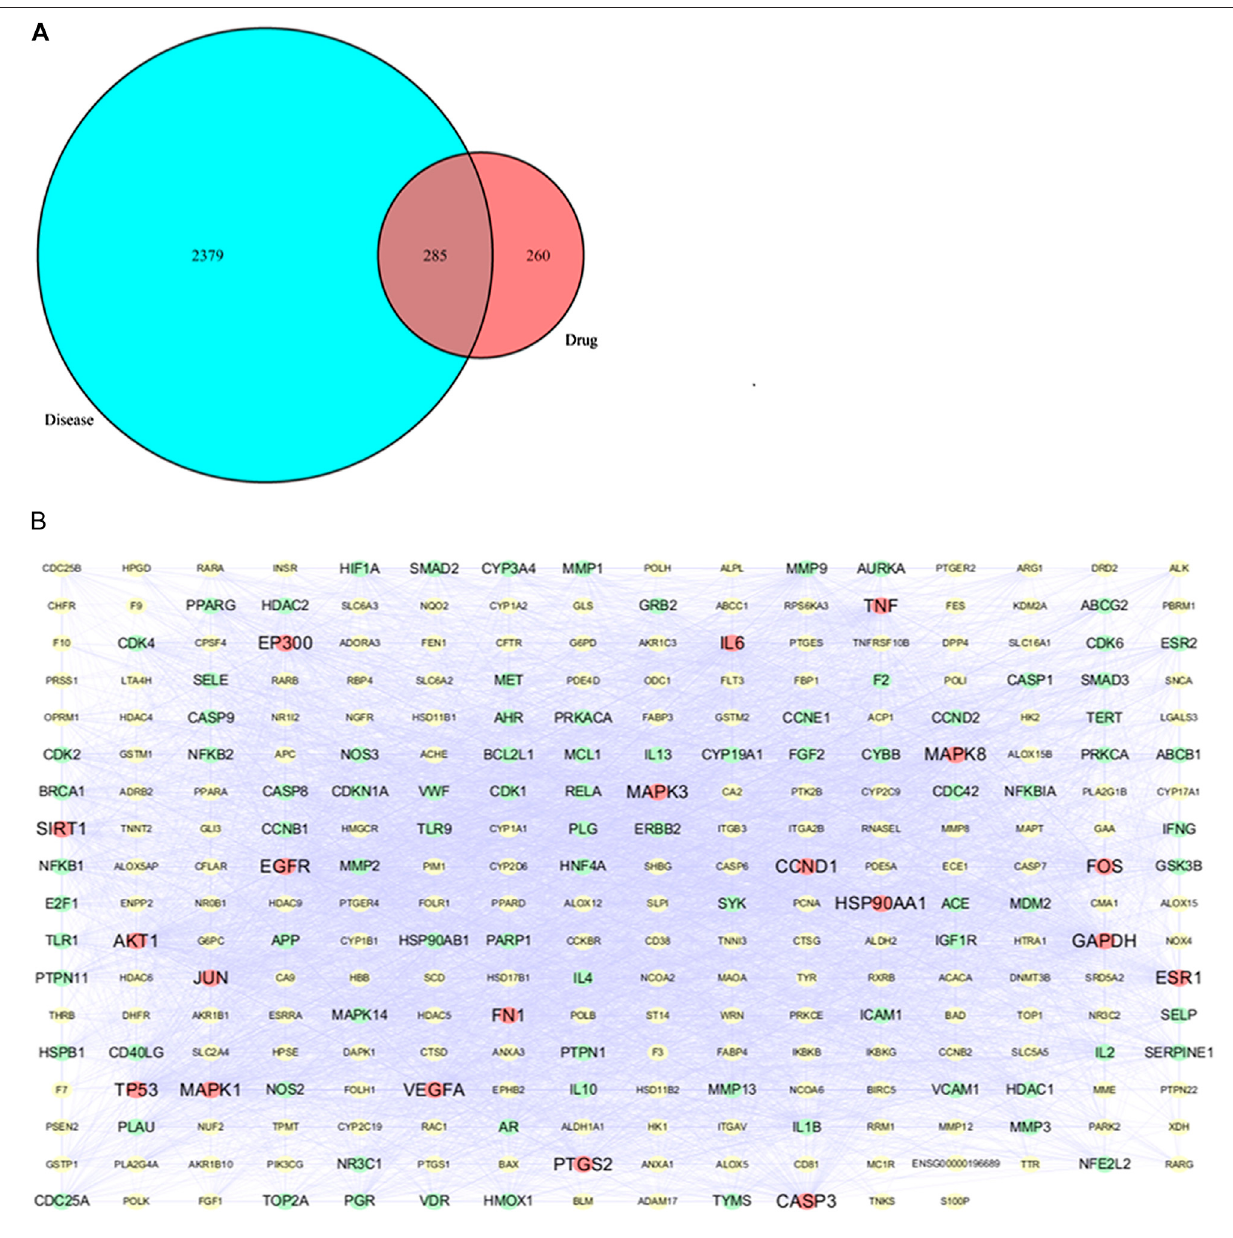
Frontiers in Pharmacology |